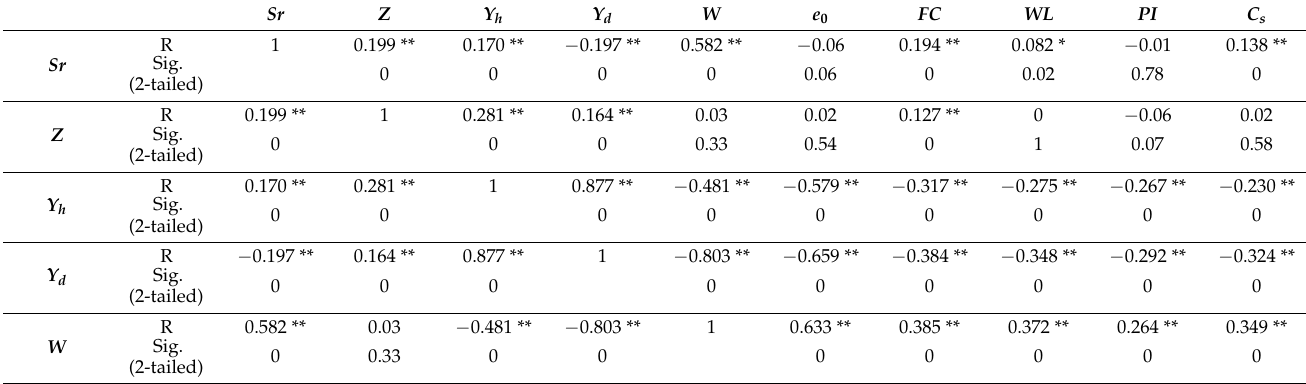
Table 5. Matrix of correlation between the geotechnical parameters (* Correlation significant at α = 0.05; ** Correlation significant at α =